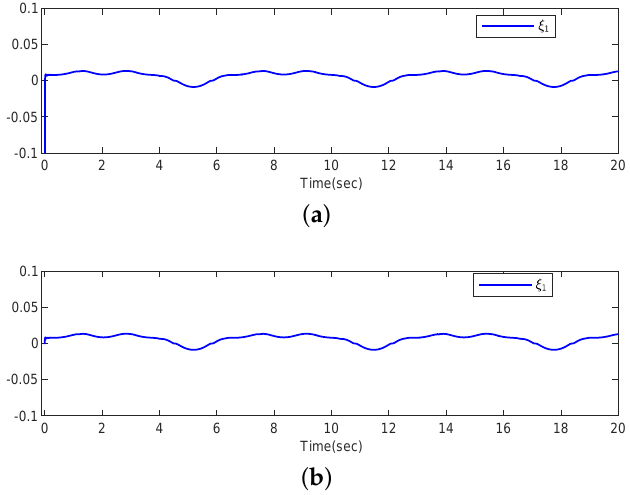
Figure 3. ( a ) Tracking error ξ 1 under case 1 . ( b ) Tracking error ξ 1 under case 2 .